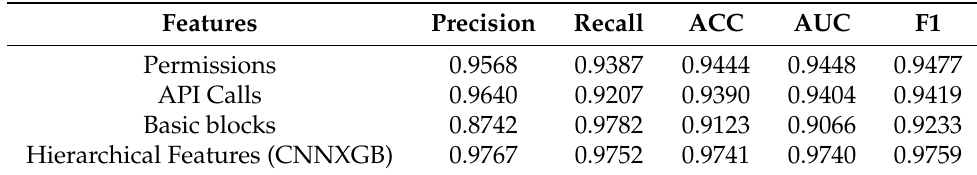
Table 14. Detection performance comparisons between hierarchical features and isolated